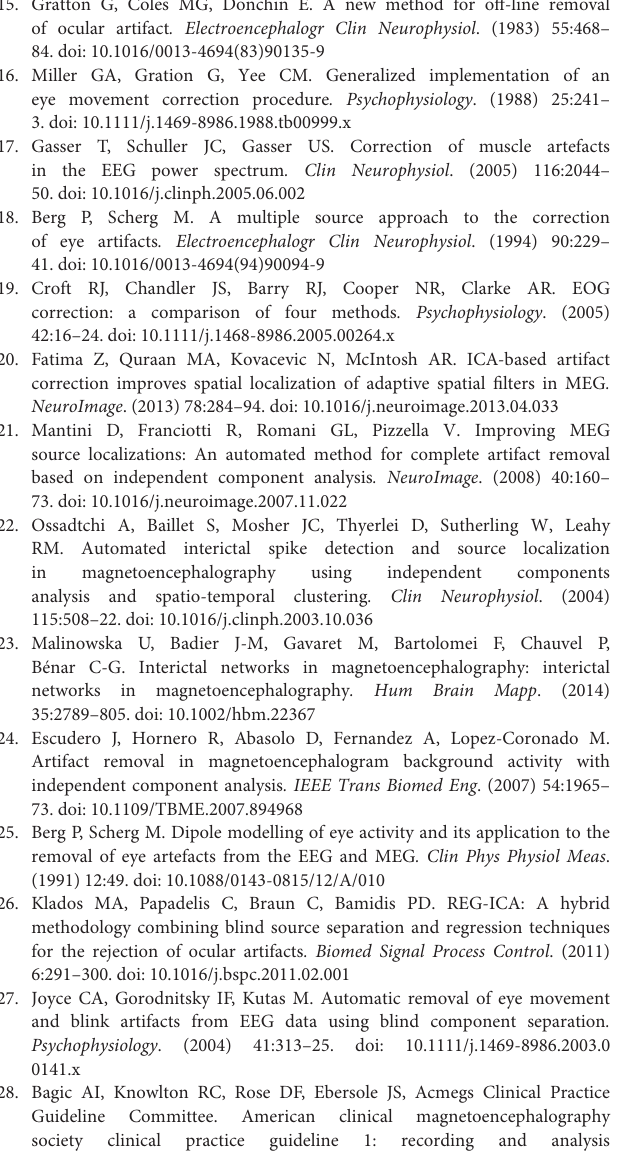
Figure S1 | Example of IC selection. The left side of the picture shows the topographical distribution of the magnetic field at the peak of the average spike.